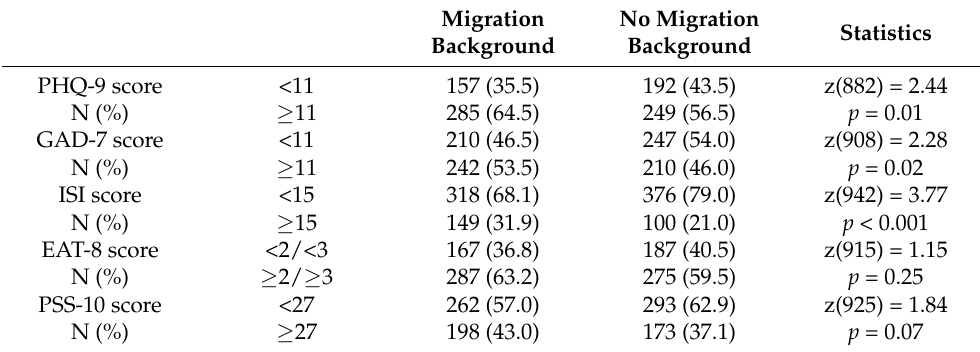
Table 2. Prevalence of moderate depressive symptoms, anxiety symptoms, clinical insomnia, eating symptoms, and high stress by migration status (matched pairs N = 958).